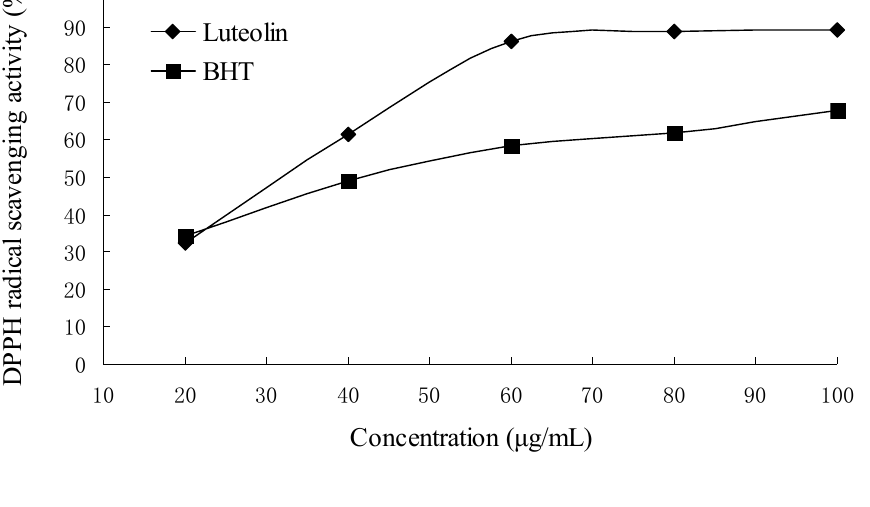
Figure 6. DPPH radical scavenging activity of BHT and luteolin-phospholipid